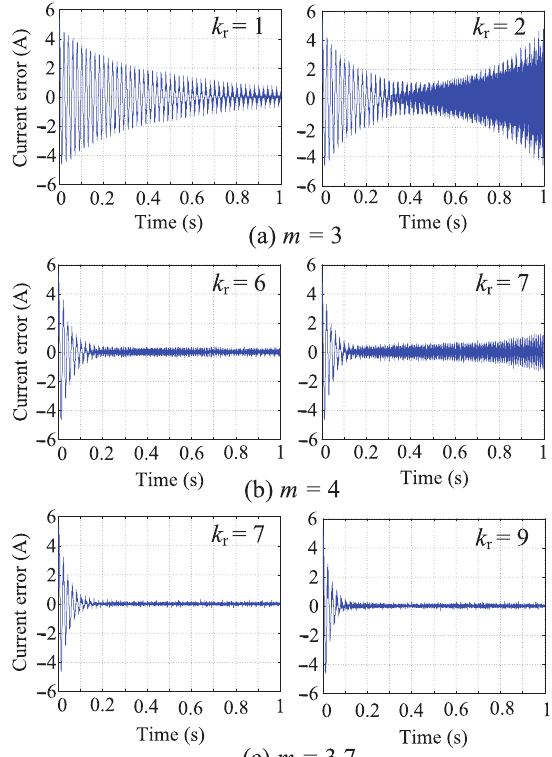
Figure 8. Diagrams of current error convergence with different values of m : ( a ) m = 3, ( b ) m = 4, ( c ) m =